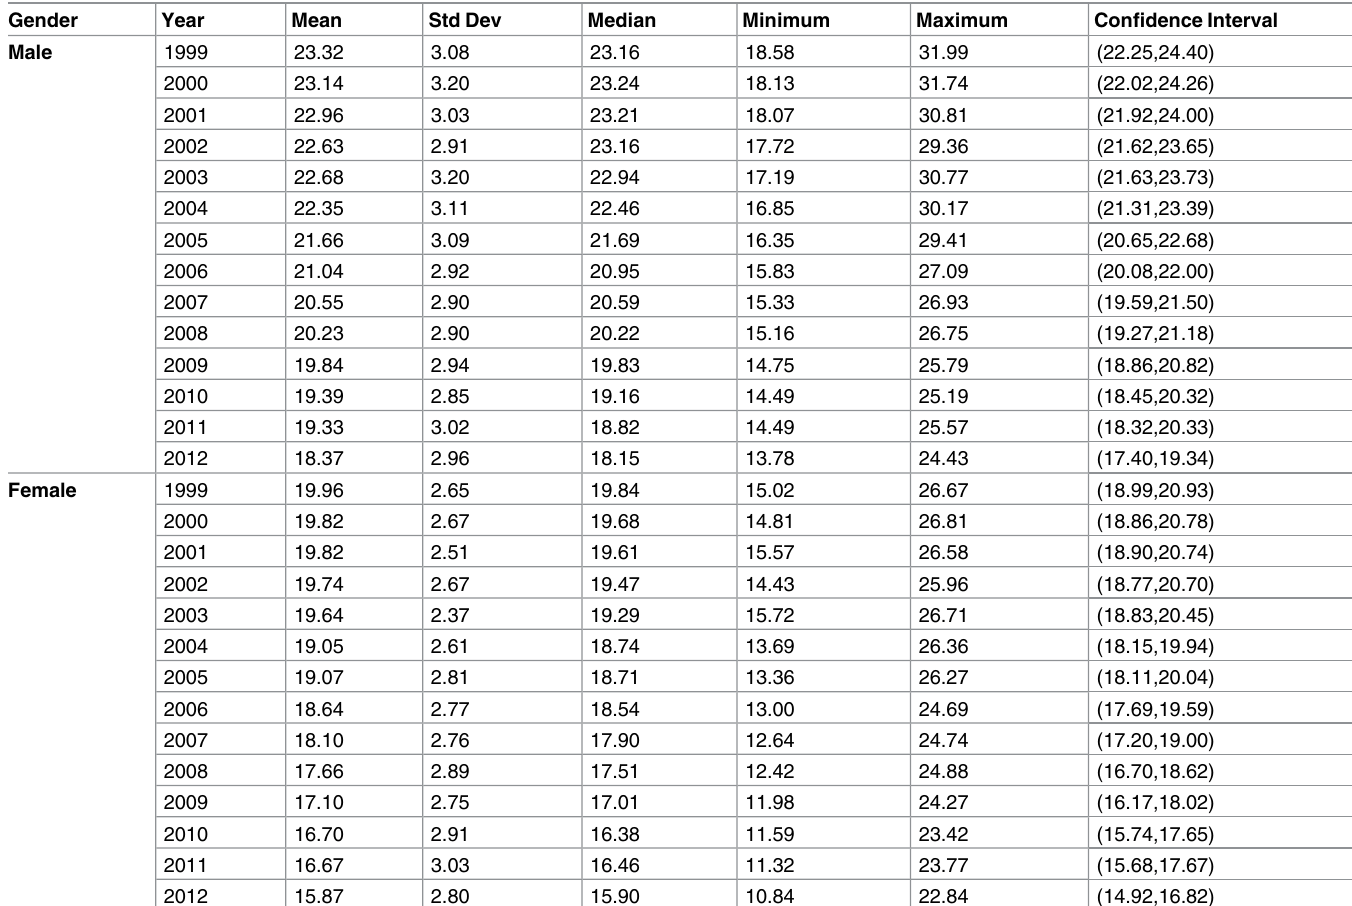
Table 12. Summary statistics of the mean percent of daily males and females smokers for 38 states and District of Columbia, 1999–2012. Gender